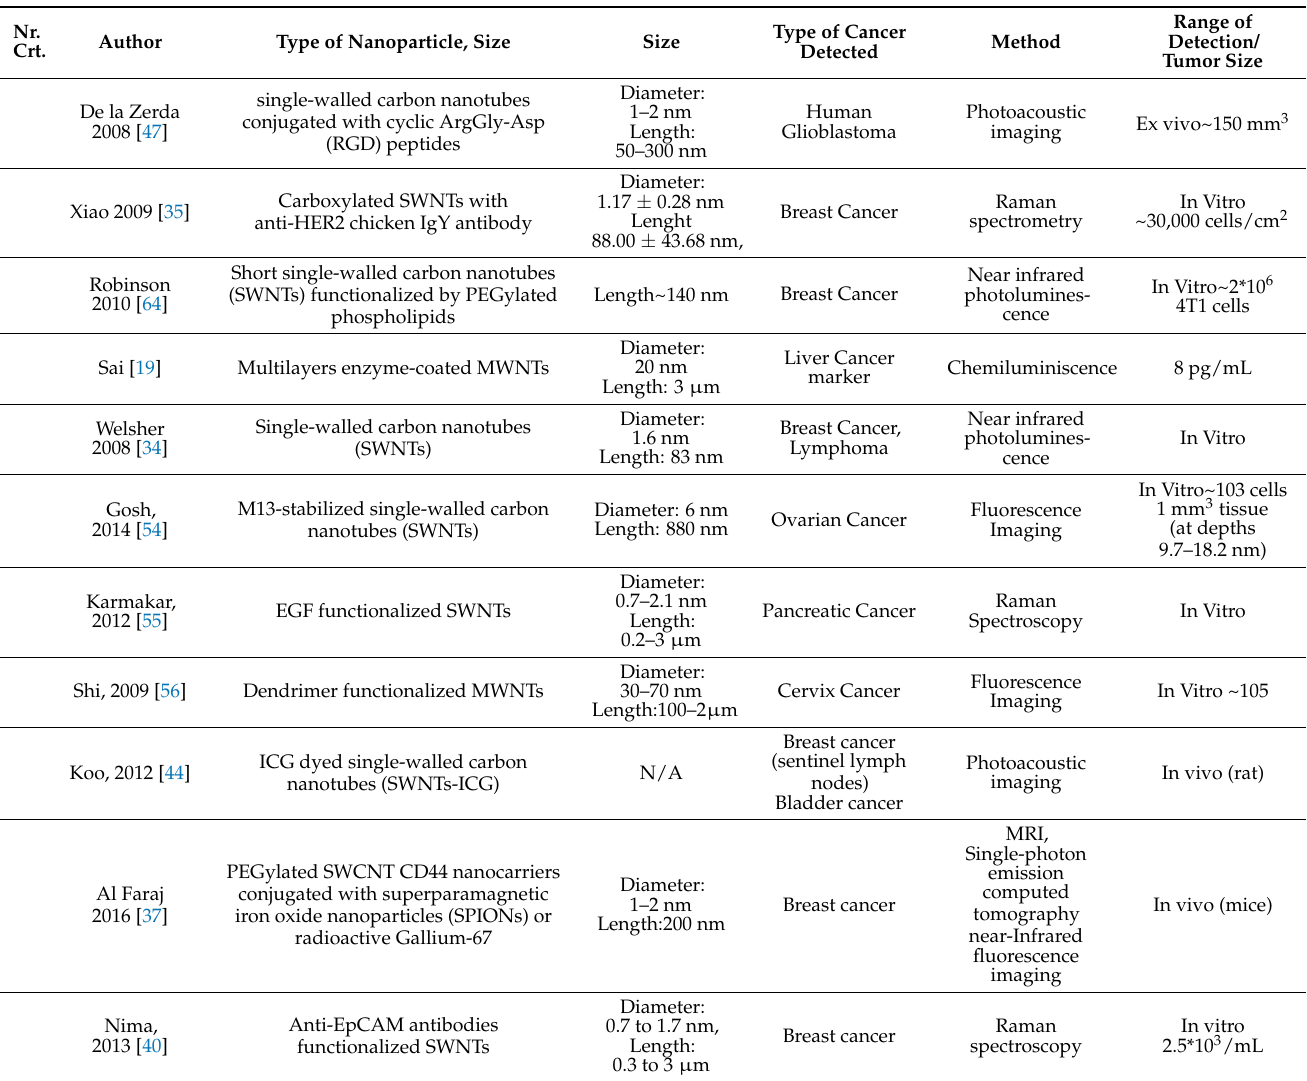
Table 1. Cabon-based nanoparticles used in cancer